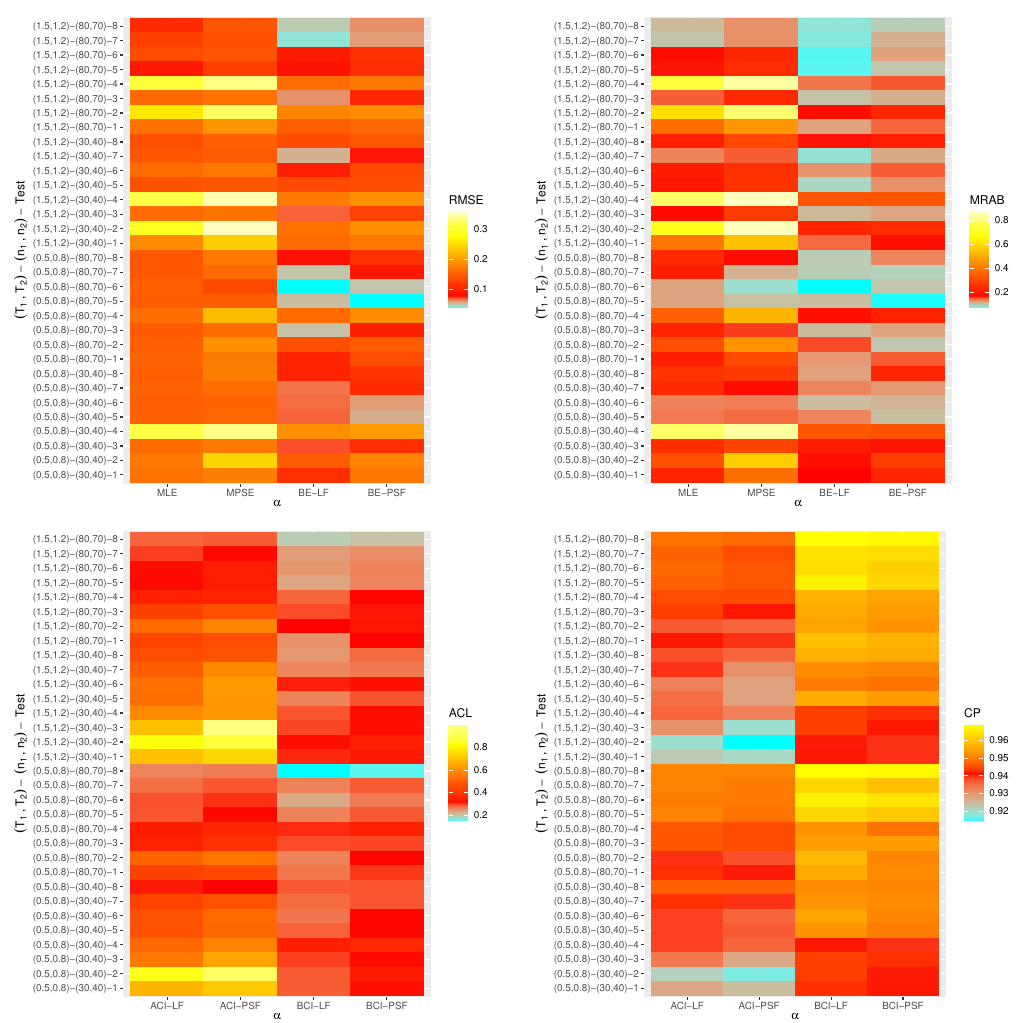
Figure 3. Heatmap for the estimation results of α using Set 1.